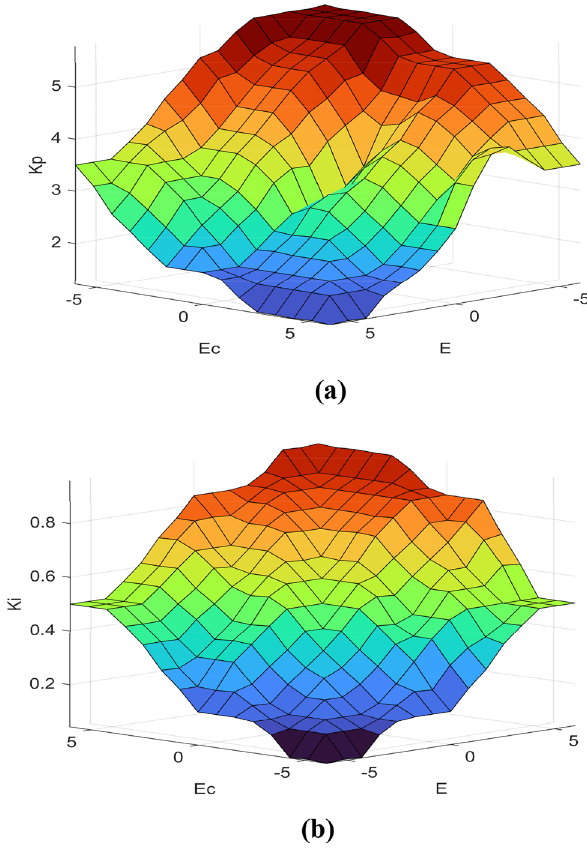
Fig. 4 Surface viewer of rules a relationship of e , ec and Kp and b relationship of e , ec and Ki